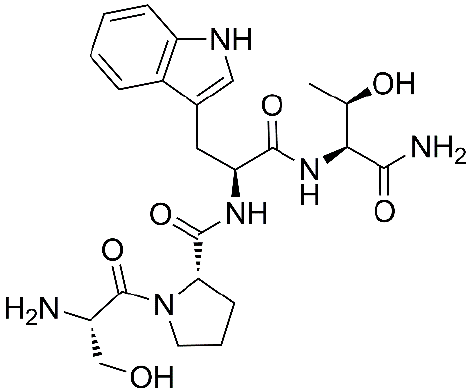
Figure 1. Chemical structure of FS10.